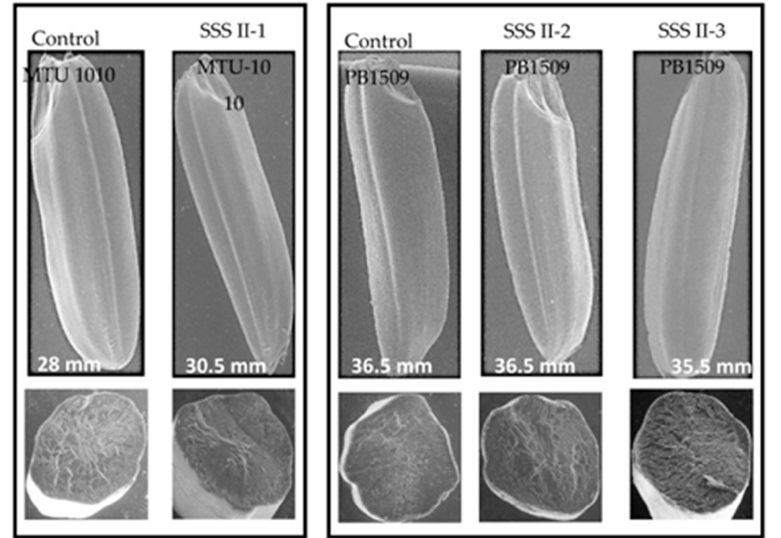
Figure 10. SEM images of whole rice grains and their transverse sections (at 80×) in Control (wt) versus knockout mutants of SSSII-1/2/3 in MTU-1010 and PB1509.